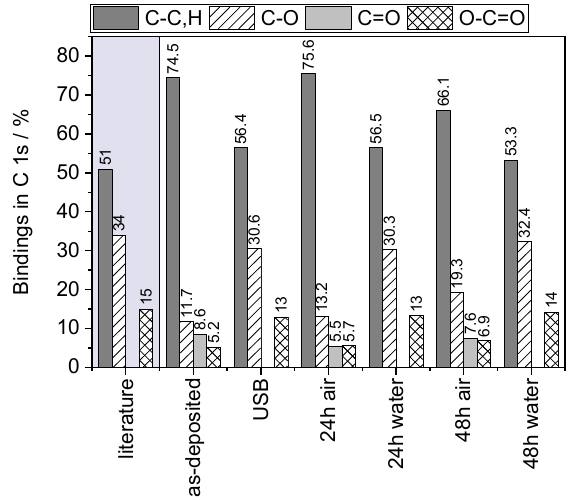
Figure 8. Functional group distribution of the coatings determined from XPS high-resolution C 1s spectra. Data obtained from the literature are based on [59].